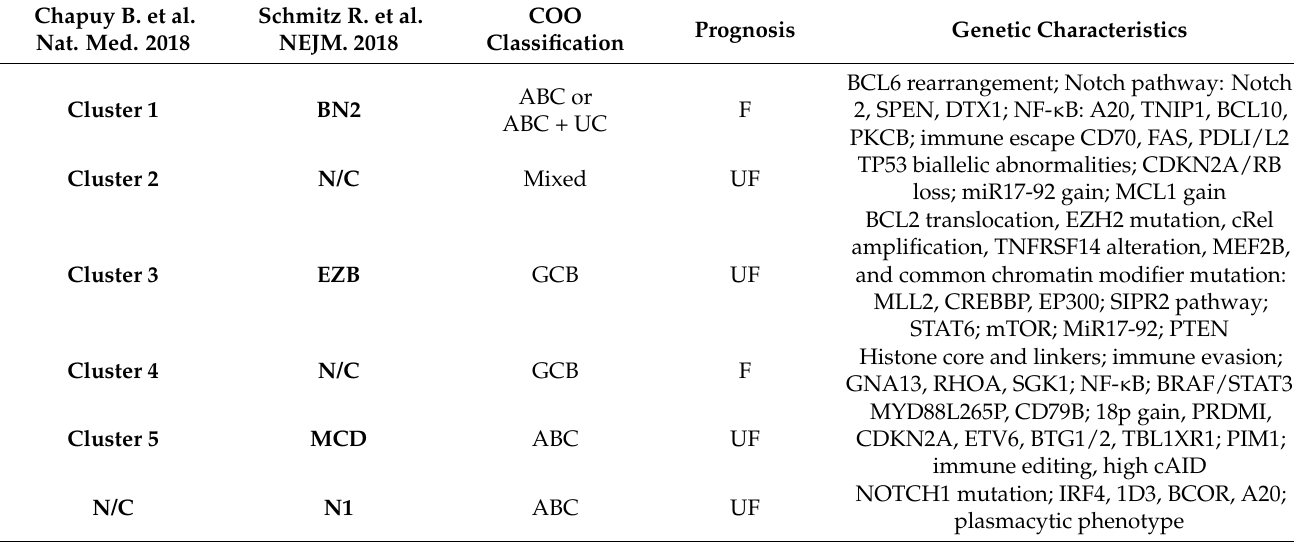
Table 1. Comparison of two genetic classification schemes for